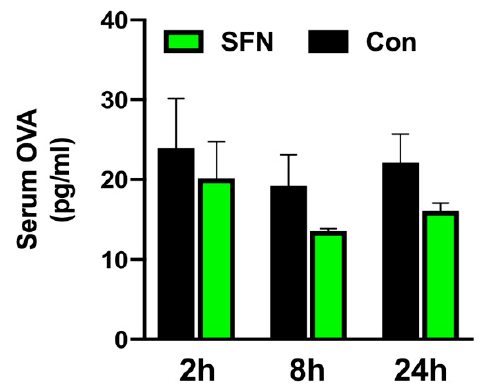
Figure 6. Protection of intestinal barrier function was analyzed by OVA translocation to the serum in control (CON) and SFN-treated (SFN) animals after 2, 8 and 24 h of reperfusion. All data are presented as mean values ± SEM. n = 6 animals per group.